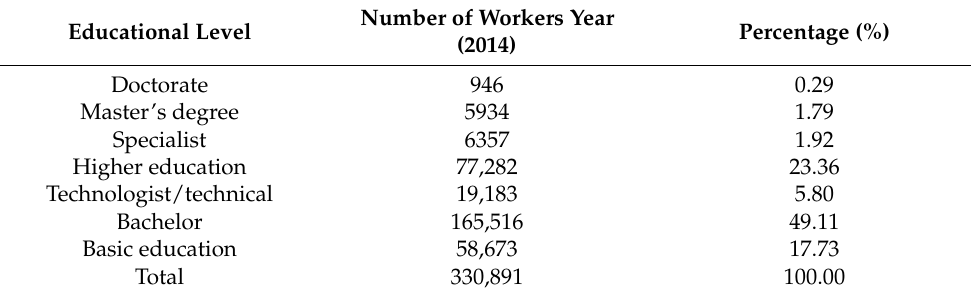
Table 5. Educational level of company staff.